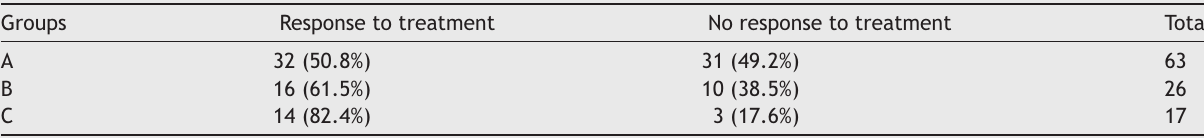
The groups’ response to the treatment. Groups Response to treatment